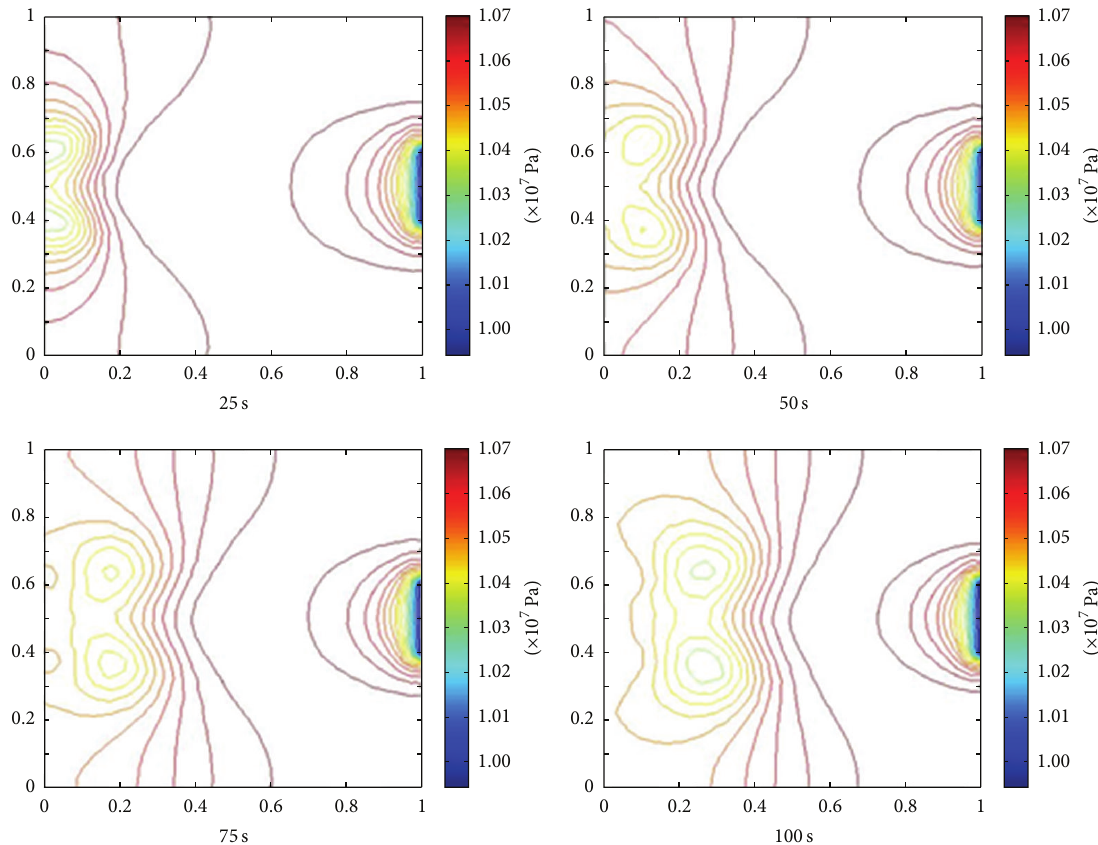
Figure 6: Pressure profile patterns of the free-flow region at different